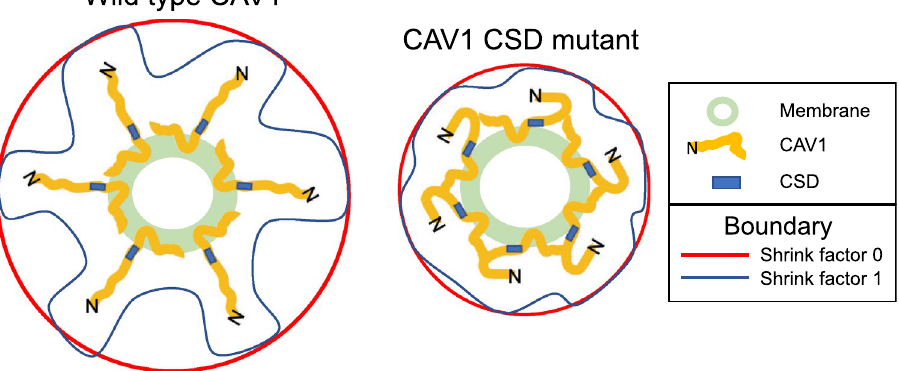
Figure 7. Schematic diagram of convex hull analysis of CAV1 WT and CSD mutant scaffold blobs. Increased variance of the convex hull boundary at high shrink factors (most indented) compared to low shrink factors (the most convex) is suggestive of the more variable distribution of N-terminal CAV1 labeling in CAV1 WT relative to CAV1 CSD mutant scaffold domains. CSD indicated by blue box and N-terminus of CAV1 by N. Membrane is in green and convex hull boundary of CAV1 point clouds at shrink factor 1 in blue and at shrink factor 0 in red. Representative CAV1 domains are shown containing 6 CAV1 ′ s and do not correspond in size, number or scale to any known CAV1 scaffold. Adapted from 39